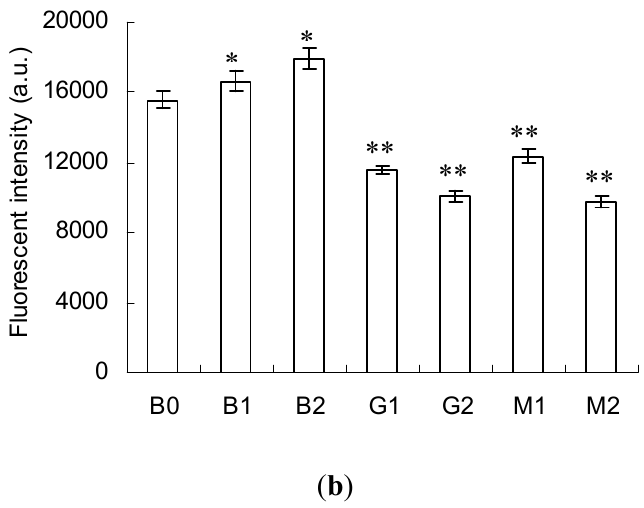
Figure 3. Fluorescence emission maximum ( a ) and fluorescence intensity ( b ) of BSA, BSA–glucose and BSA–mannose at intensities 10 and 20 kV/cm. Data are mean ± standard deviation, n = 3. * p < 0.05, ** p < 0.01 versus control (B0).